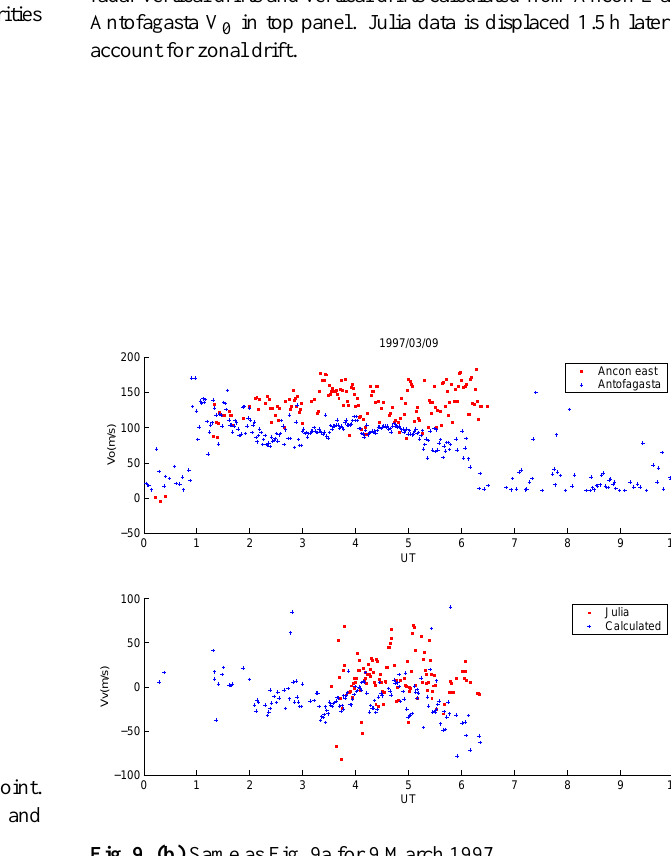
Fig. 9. (b) Same as Fig. 9a for 9 March